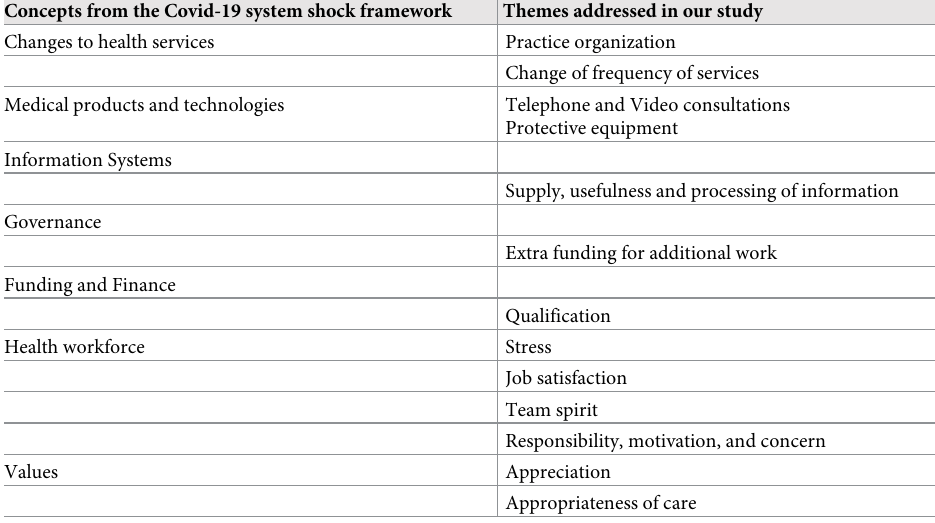
Table 1. The COVID-19 system shock framework and themes in the